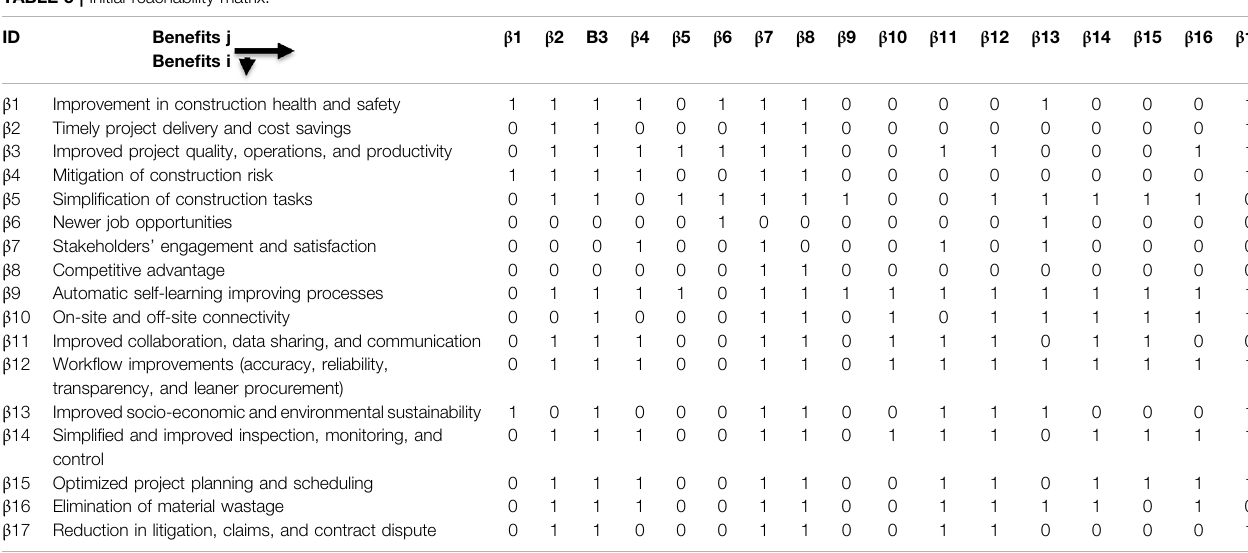
TABLE 5 | Initial reachability